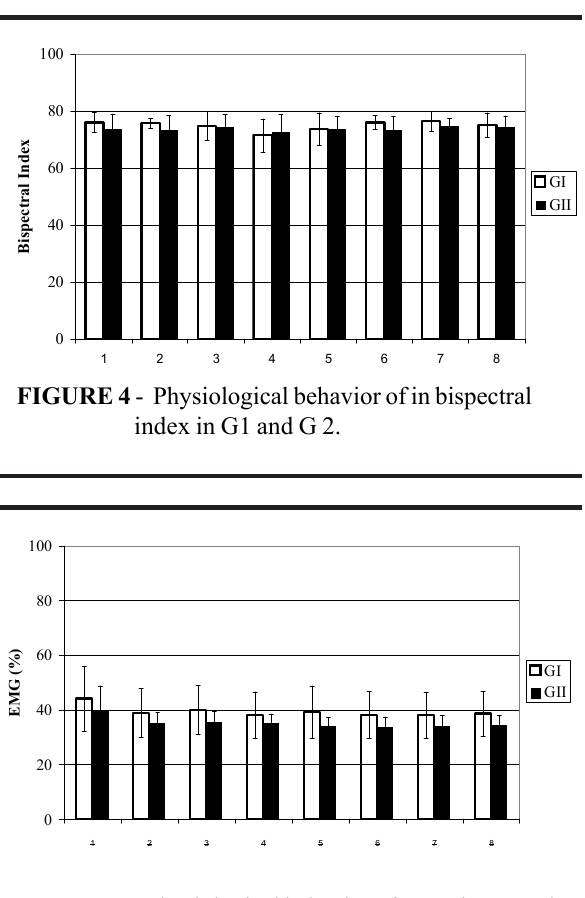
FIGURE 2 - Physiological behavior of systolic, average and diastolic arterial pressure (SAP, MAP, DAP) in G1 and G2.